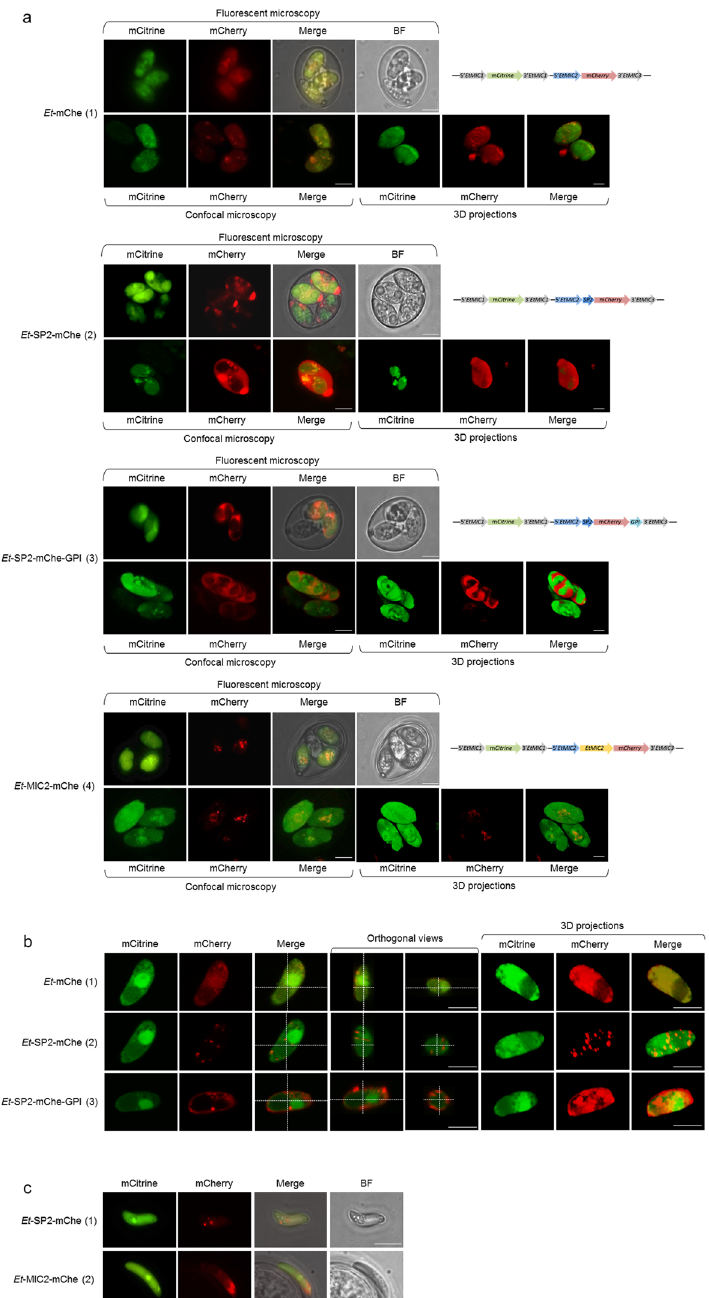
Figure 2. Fluorescent patterns observed in stable transgenic populations of E. tenella (mCitrine was always observed in the cytosol for all the populations at all different stages). ( a ) Micrographs of oocysts of the transgenic populations: fluorescent microscopy ( 1 ), confocal microscopy ( 2 ) and 3D projections. Oocysts can contain a variable number (1 to 4) of fluorescent sporocysts. (1) E t-mChe: cytosolic expression of mCherry; (2) E t-SP2-mChe: extracellular expression of mCherry, accumulated in the sporocyst cavity; (3) E t-SP2-mChe-GPI: uneven surface expression of mCherry; (4) E t-MIC2-mChe: intracellular expression of mCherry, accumulated in cytoplasmic vesicles. ( b ) Fluorescent patterns, orthogonal views ( 2 ) and 3D projections ( 3 ) of intracellular sporozoites. (1) Et -mChe: mCherry in the cytosol; (2) Et -SP2-mChe: mCherry in vesicles in the cytoplasm; (3) Et -SP2-mChe-GPI: mCherry on the surface with different degrees of aggregation. ( c ) Hatched sporozoites ( 1 ). (1) E t-SP2-mChe: mCherry is observed in vesicles in the anterior part of the sporozoite; (2) E t-MIC2- mChe: apical expression of mCherry. ( 1 ) Micrographs taken with DCF365FX camera using a Leica DMI3000B fluorescent microscope; ( 2 ) Leica Confocal microscope SP5; ( 3 ) 3D projections are derived from different positions along the z-axis of the confocal micrographs (z stacks) processed with Velocity software version 6.3, rotation of the images was done to show an improved view of the mCherry distribution. BF = Bright field. Bars represent 5 µ